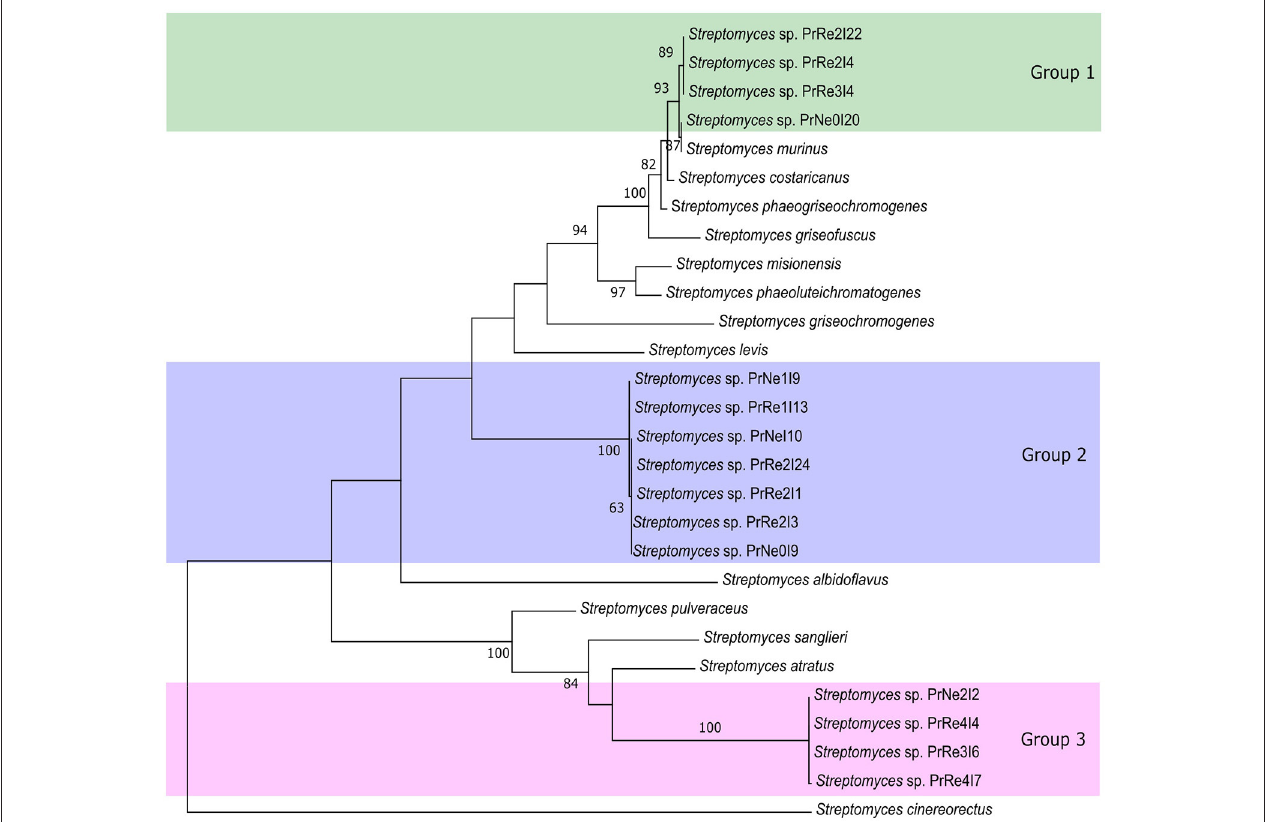
FIGURE 3 | Maximum likelihood tree showing phylogenetic placement of our isolates based on concatenated 16S rRNA- trpB - rpoB - gyrB alignments. Only bootstrap values above 65% are indicated. Shaded areas indicate groups of isolates.